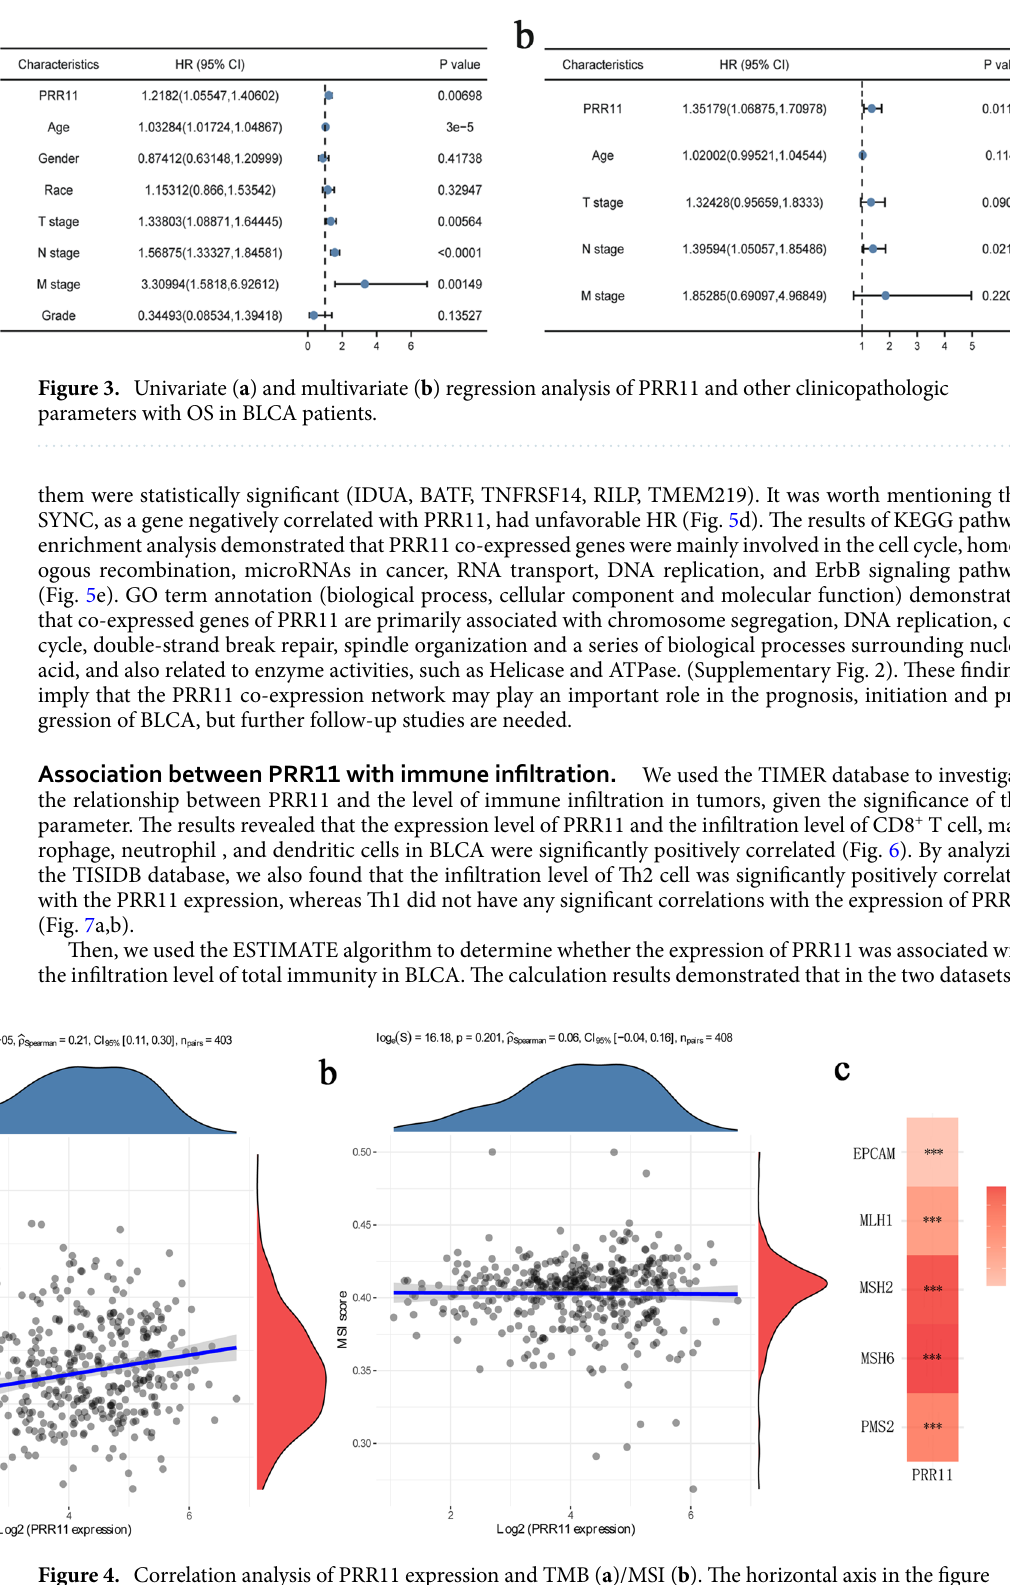
Figure 4. Correlation analysis of PRR11 expression and TMB ( a )/MSI ( b ). The horizontal axis in the figure represents the expression distribution of the gene, and the ordinate is the expression distribution of the TMB/ MSI score. The density curve on the right represents the distribution trend of the TMB/MSI score; the upper density curve represents the distribution trend of the gene; the value on the top side represents the correlation p value, correlation coefficient and correlation calculation method. ( c ) Heatmap illustrating the association between PRR11 expression and MMR genes. The gene correlation heatmap is realized by the R (v4.1.0) software package “ggstatsplot”. *** P <